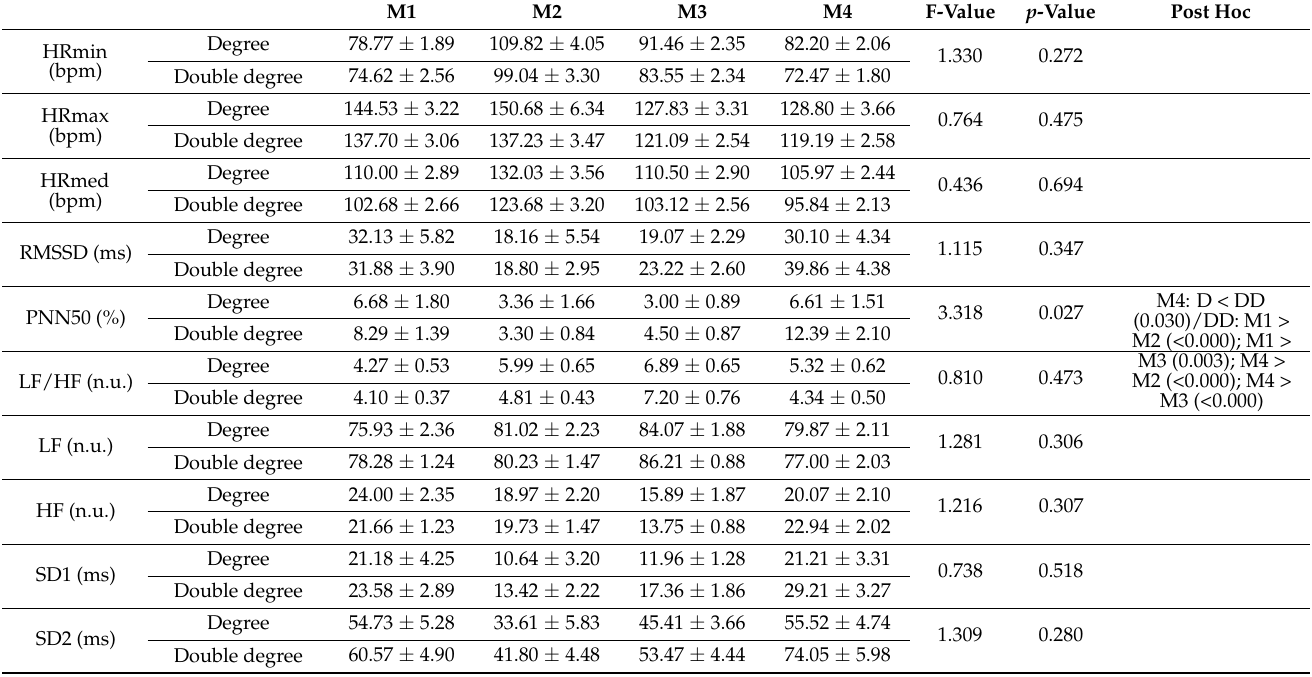
Table 1. Changes (Mean ± SD) in the autonomic stress response to the bachelor’s thesis according to whether students attended a degree or double-degree bachelor’s course. M1 M2 M3